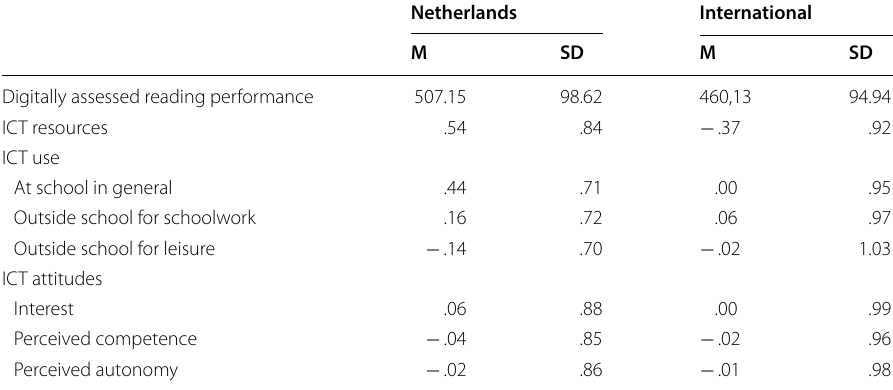
Table 1 Means and SD for digitally assessed reading performance, ICT resources, ICT use, and ICT attitudes